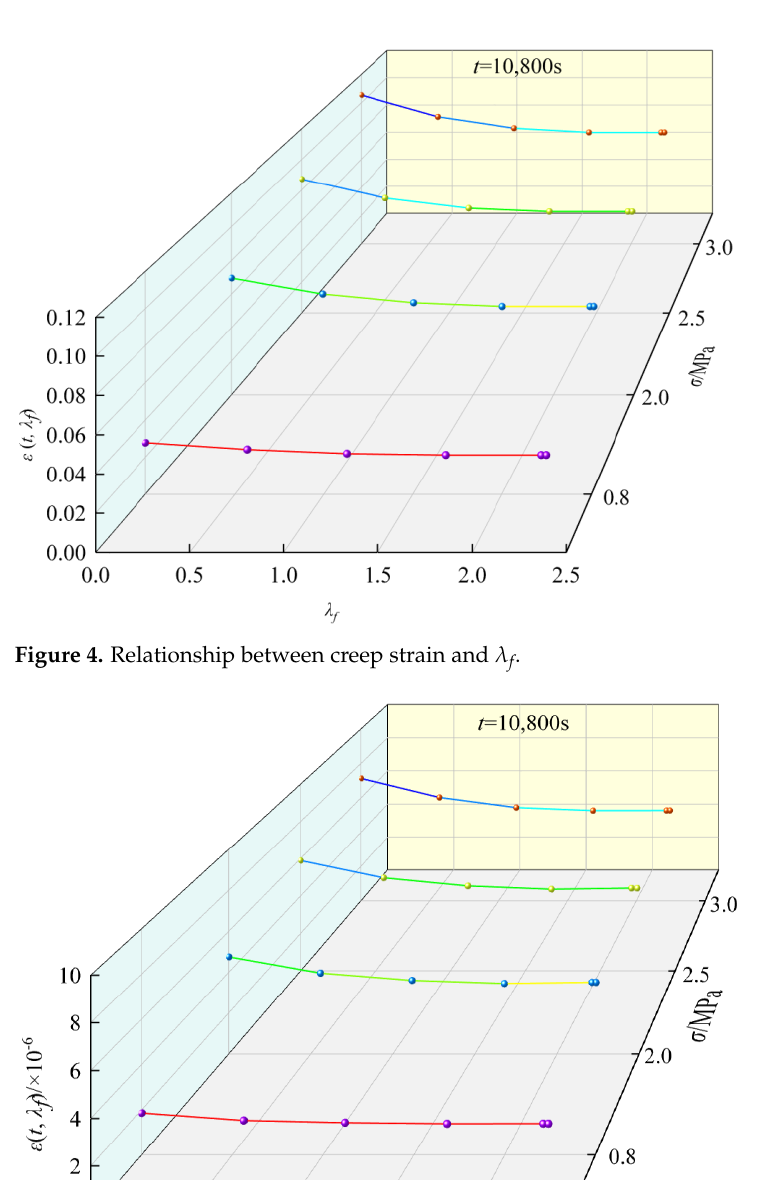
Figure 5. Relationship between creep rate and λ